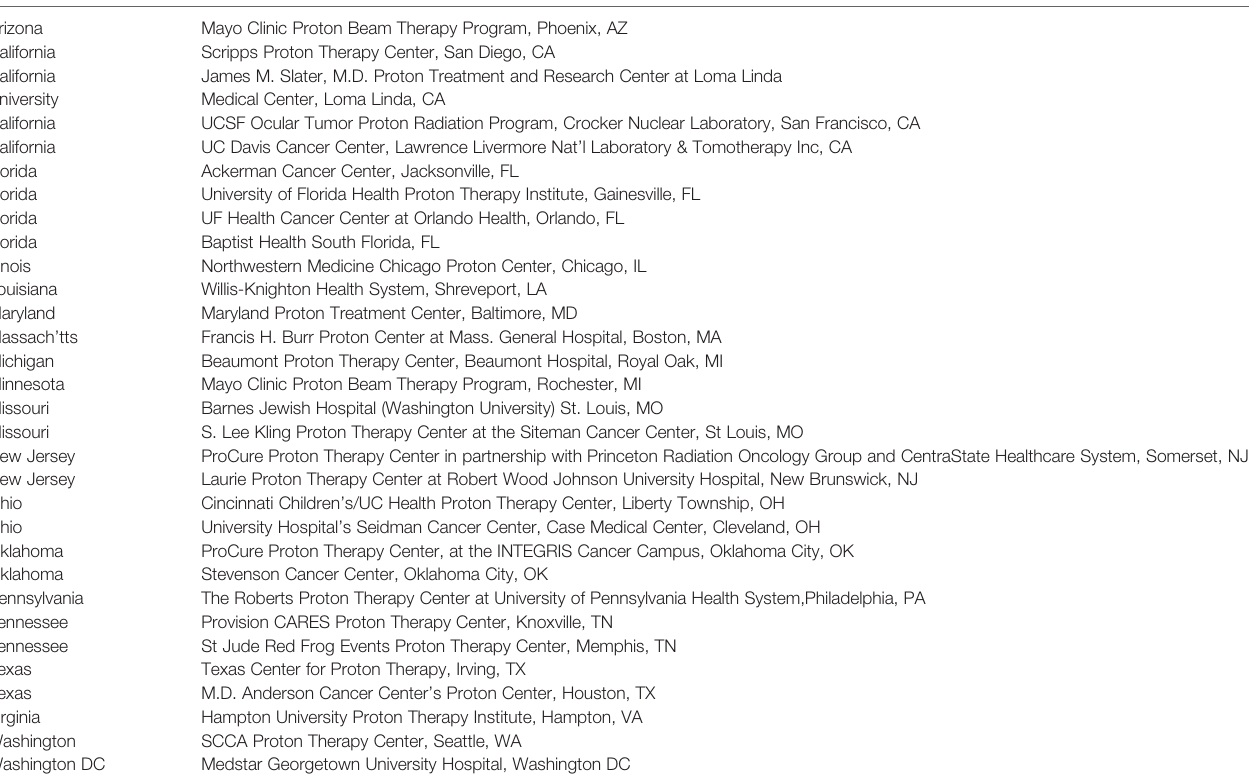
TABLE 3 | Proton therapy centers in the US (3, 4).